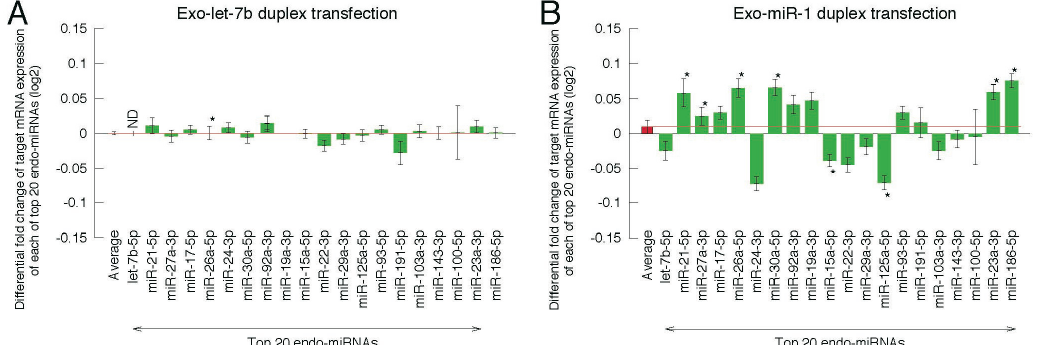
Figure 3. Mean fold changes of the expression levels of endo-miRNA target transcripts following the transfection of exo-miRNAs. HeLa cells were transfected with each of mean differential fold changes of the expression levels fifteen exo-miRNA duplexes, log 2 of seed-matched target genes of each of the top 20 endo-miRNAs were calculated. Data were shown with respect to transfected exo-miRNAs, miR-7b ( A ); miR-1 ( B ); miR-21 ( C ); miR-22 ( D ); miR-28 ( E ); miR-30c-1 ( F ); miR-186 ( G ); miR-199b ( H ); miR-200b ( I ); miR-330 ( J ); miR-335 ( K ); miR-346 ( L ); miR-466 ( M ); miR-574 ( N ); miR-3126 ( O ); and their averaged values were shown in ( P ). Target genes of different endo-miRNAs are increased by exo-miRNAs in approximately comparable levels. The individual data are shown in Figures S2–S21. Data represent the mean ± SE ( * p <